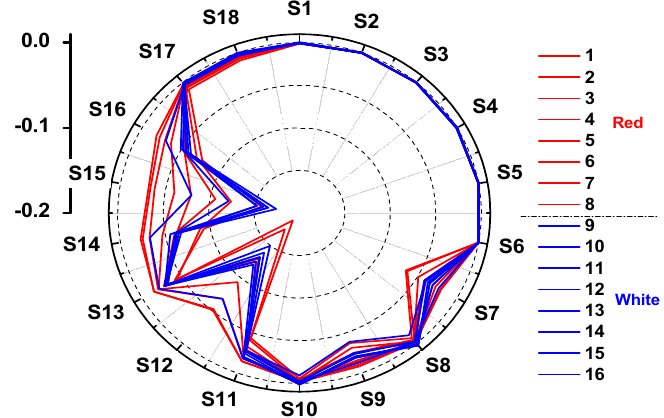
Figure 1. Polar plots of the fingerprints (the maximum or minimum response values) of typical peach samples. S1 to S18 means 18 sensors equipped by e-nose. Names of peach sample from 1 to 16 are shown in Table 1.